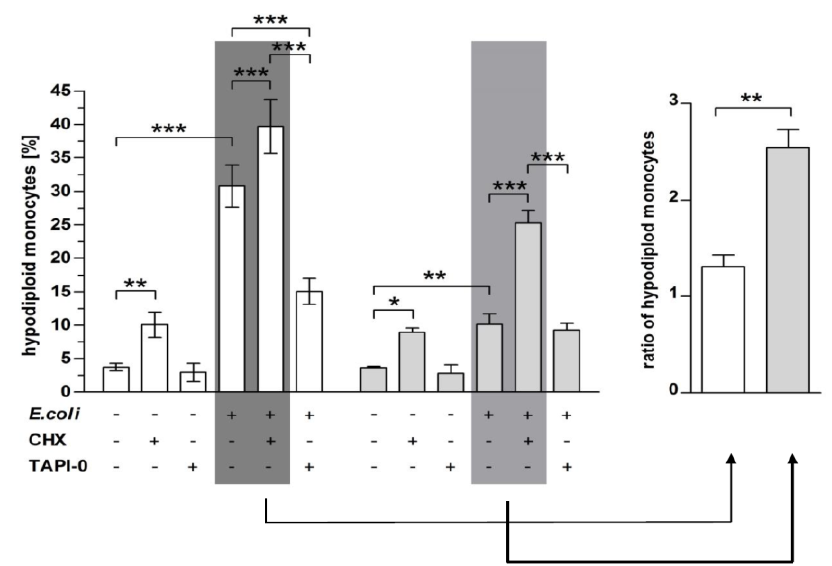
Figure 3. Blockage of MMP-9 increased PICD of CBMO. PBMO and CBMO were infected and/or treated with the indicated metalloproteinase inhibitors. Apoptosis was determined by Nicoletti assay 24 h p.i. The right panel gives the ratio of the values highlighted in dark-grey and grey, respectively ( n = 5, * p < 0.05, ** p < 0.01, *** p < 0.001, forked bars represent Student’s t -test, blunt-ended bars represent ANOVA).